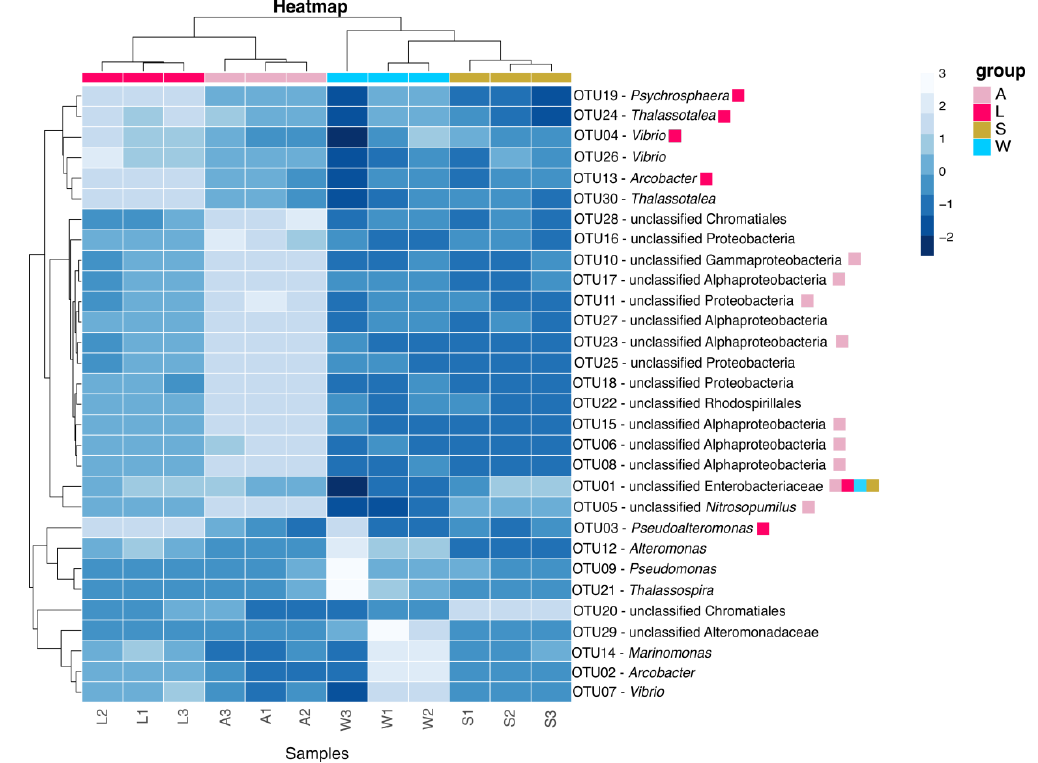
Figure 5. Heatmap with the top 30 most abundant OTUs detected in the different life stages of the marine sponge P. cyanorosea , ambient seawater and sediment. For plotting purposes, Z-transformation was applied for the logarithmic conversion of the total read count for each top OTU. The OTUs comprising the strict core microbiota for all samples, adults and larvae are highlighted as squares colored according to the legend (upper left). A: adults; L: larvae; W: seawater; S: sediment. Moreover, 14 out of these top30 abundant OTUs (OTU1, OTU3, OTU5, OTU7, OTU12, OTU13, OTU14, OTU17, OTU19, OTU20, OTU21, OTU24, OTU26; Table S4) were 100% identical to OTUs